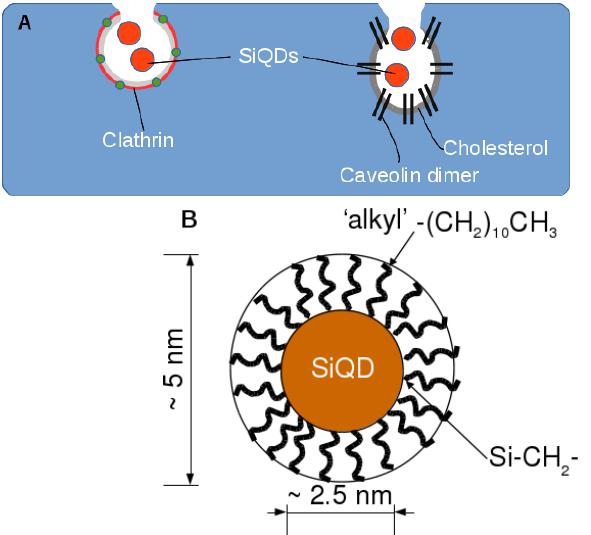
Figure 1. ( A ) Simplified schematic of the initial stages of two selected mechanisms of endocytosis. On the left, clathrin-mediated endocytosis and on the right, cholesterol-dependent endocytosis in caveolae. The orange discs represent SiQDs undergoing endocytosis; their size is exaggerated compared to the clathrin/caveolin coated pit dimensions of 50–100 nm. ( B ) Schematic of an alkyl SiQD. The luminescent QD core is crystalline Si of approximate diameter 2.5 nm. The QD is capped by n-alky chains anchored to the surface of the core by Si-C bonds. The total diameter of the particle is about 5